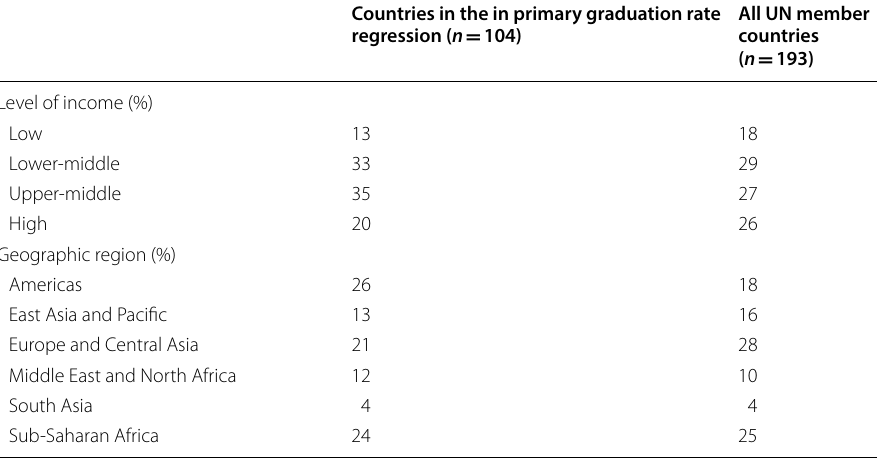
Table 1 Description of analytic sample compared with sample of all UN member states: income level and geographic